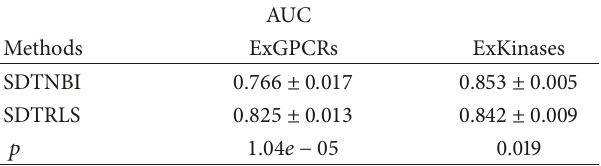
Table 6: The 𝑡 -tests results of two external validations.